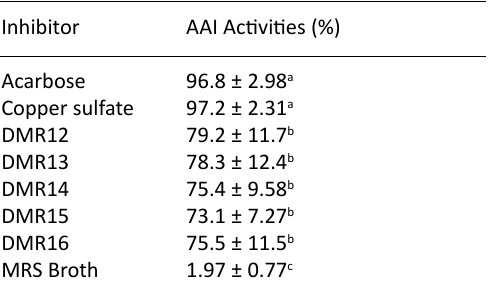
Table 1. AAI activities of culture-free supernatant of LAB